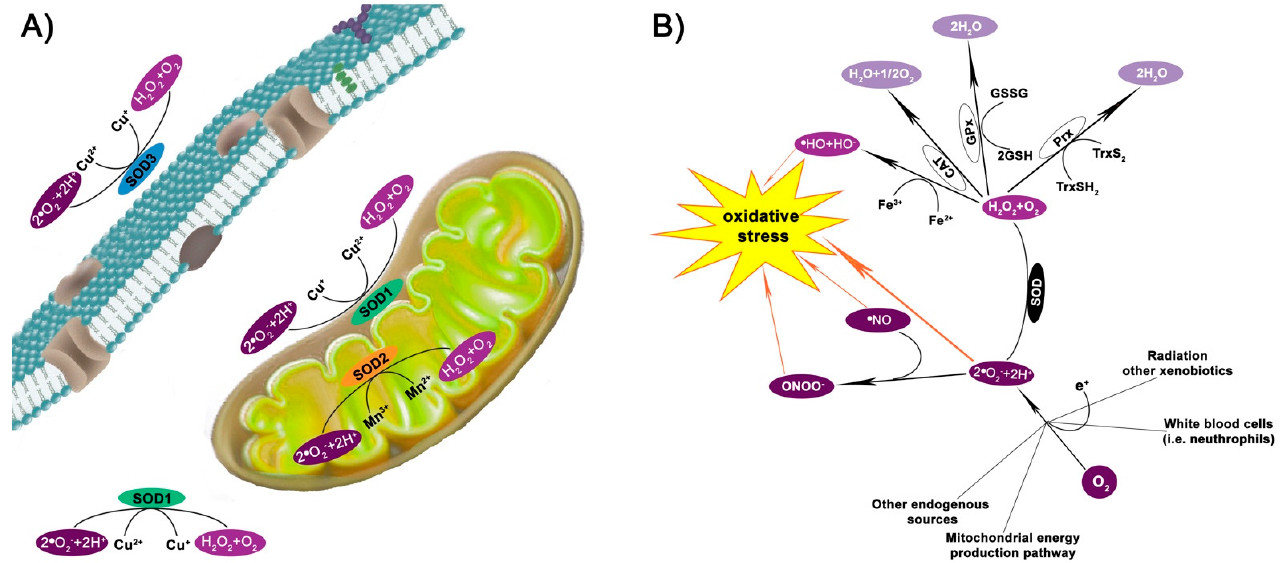
Figure 1. Superoxide dismutase enzymes. ( A ) Superoxide dismutases (SODs) are metalloenzymes constitutively expressed in eukaryotes: SOD1 is a Cu, Zn-SOD and is present in the cytosol and the mitochondrial intermembrane; SOD2 is a Mn-SOD localized in the matrix and inner membrane of mitochondria; SOD3 is a Cu, Zn-SOD expressed in the extracellular compartment. Nevertheless, all three forms catalyze the conversion of the superoxide anion free radical ( • O 2 − ) into hydrogen peroxide (H 2 O 2 ). ( B ) In detail, SOD converts the • O 2 − , generated in several cellular insults/metabolism, into H 2 O 2 and molecular oxygen (O 2 ). The resulting H 2 O 2 may undergo reduction to water via catalase (CAT), glutathione peroxidases (GPx), or thioredoxin (Trx)-dependent peroxiredoxin (Prx). Otherwise, H 2 O 2 originates • OH via the Fenton reaction in the presence of Fe 2+ . • O 2 − may also react with • NO originating the oxidant and nitrating agent peroxynitrite (ONOO − ), which further contributes to oxidative-stress damage. GSH = glutathione; GSSG = glutathione disulfide; TrxSH 2 = reduced thioredoxin; TrxS 2 = oxidized thioredoxin.